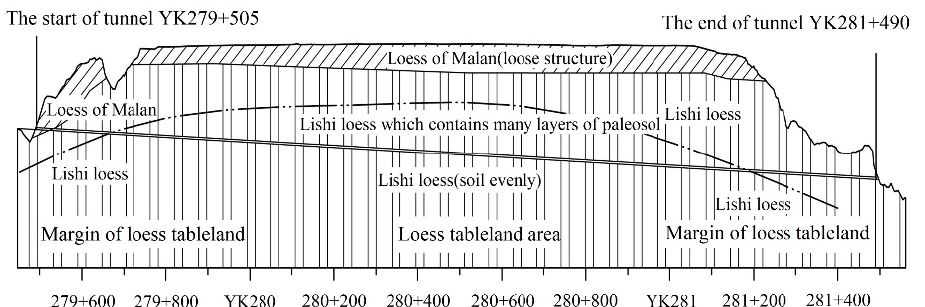
Figure 2. Geological longitudinal section of tunnel.